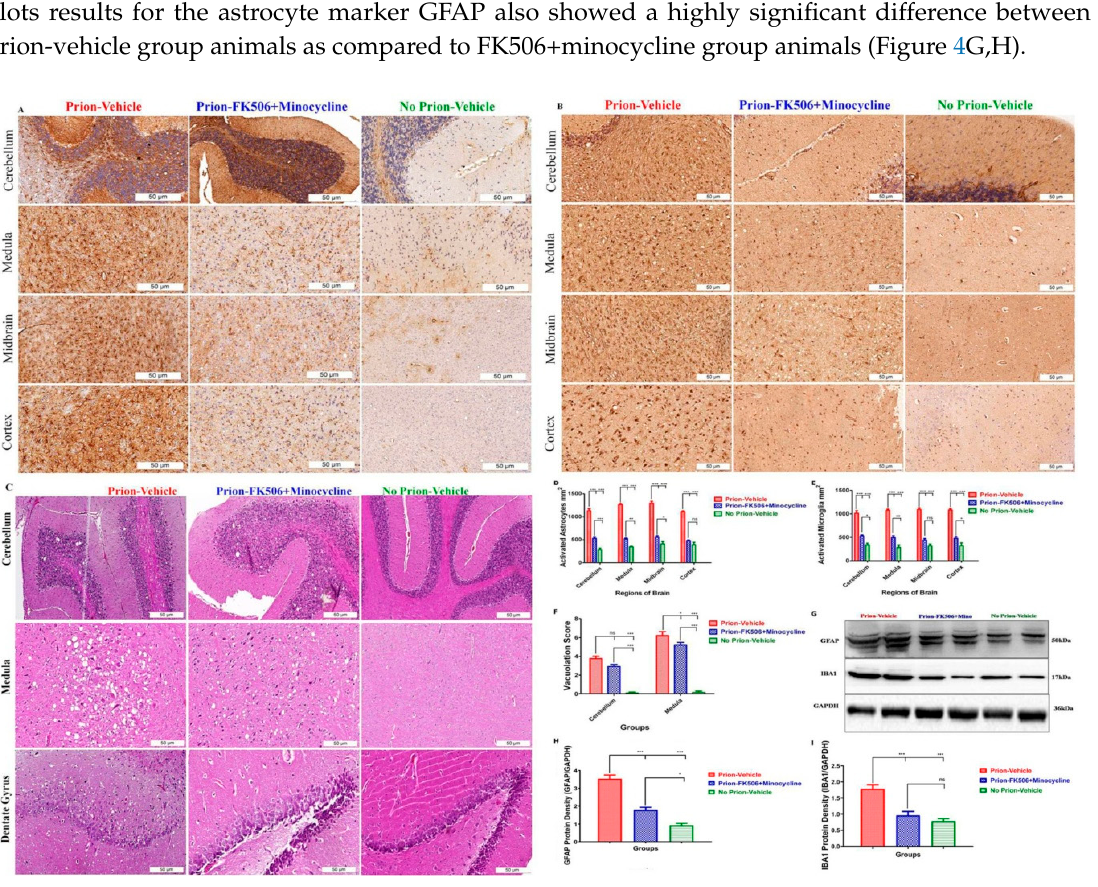
Figure 4 . FK506+minocycline treatment efficiently reduced astroglyosis in prion infected hamsters. ( A ) Representative immunohistochemistry pictures of cerebellum, medulla, midbrain, and cortex stained with GFAP antibody for activated astrocytes (scale bar-50 μ m). ( B ) Representative immunohistochemistry pictures of cerebellum, medulla, midbrain, and cortex stained with IBA1